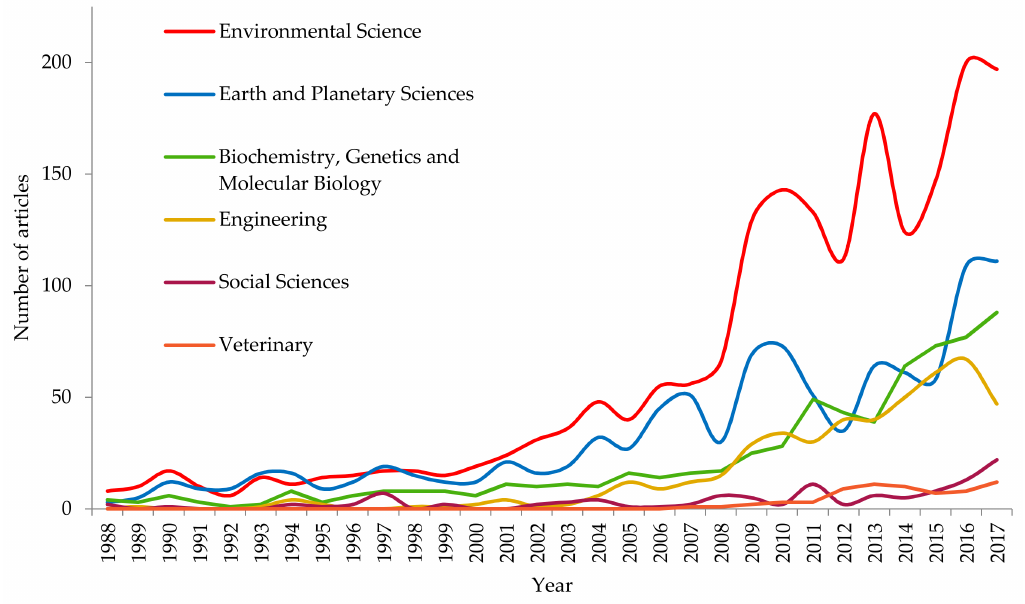
Figure 2. Comparisons of the growth trends of articles on WUEA research by subject categories from 1988 to